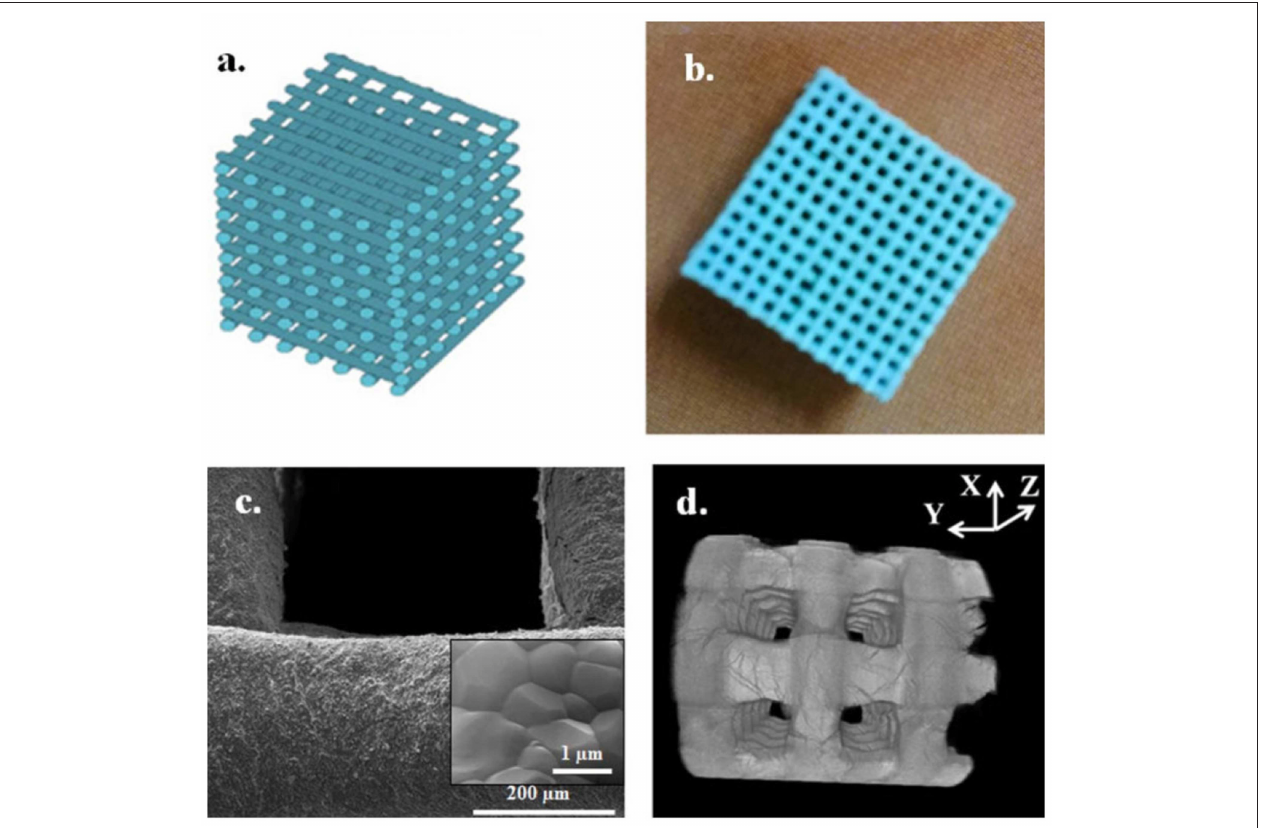
FIGURE 5 | Schematic of 3D-printed scaffold (a) , sintered 3D printed-scaffold of HAp with well-defined pores (b) , SEM image of printed scaffold showing densified microstructure of the strut surface with approximate grain size of 1 µ m (inset) (c) , and high-resolution micro-CT image of HAp-printed scaffold (d) . Reproduced from Kumar et al. (2016c) with permission from Wiley Periodicals,